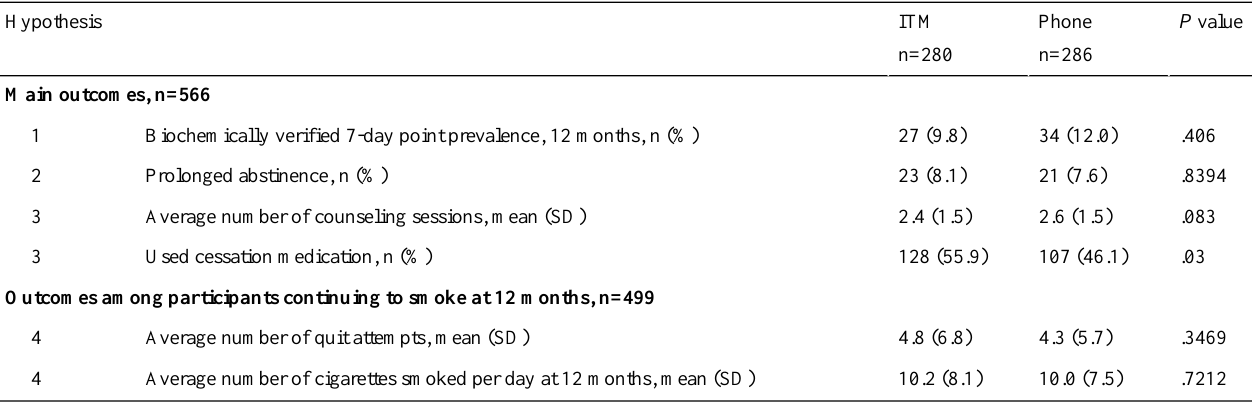
Table 2. Outcomes: Hypotheses